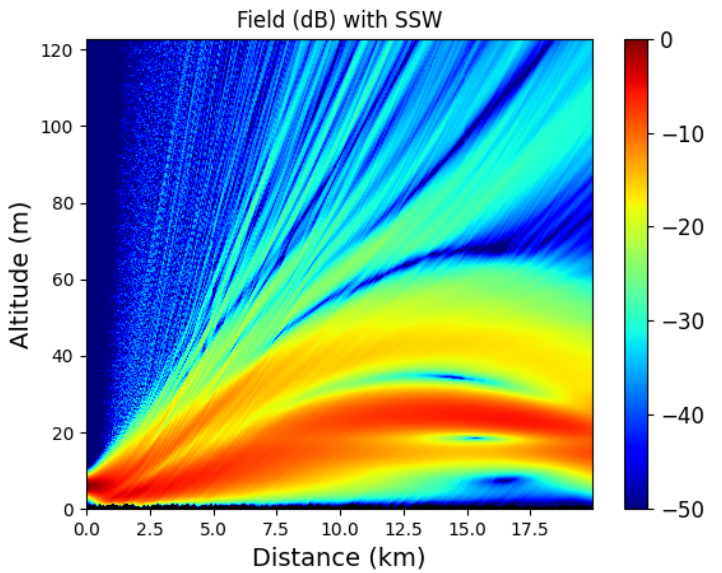
Figure 13. Worst-case scenario for the antenna coverage in terms of ship detection. In this case the source is placed z s = 5 m above the ground.